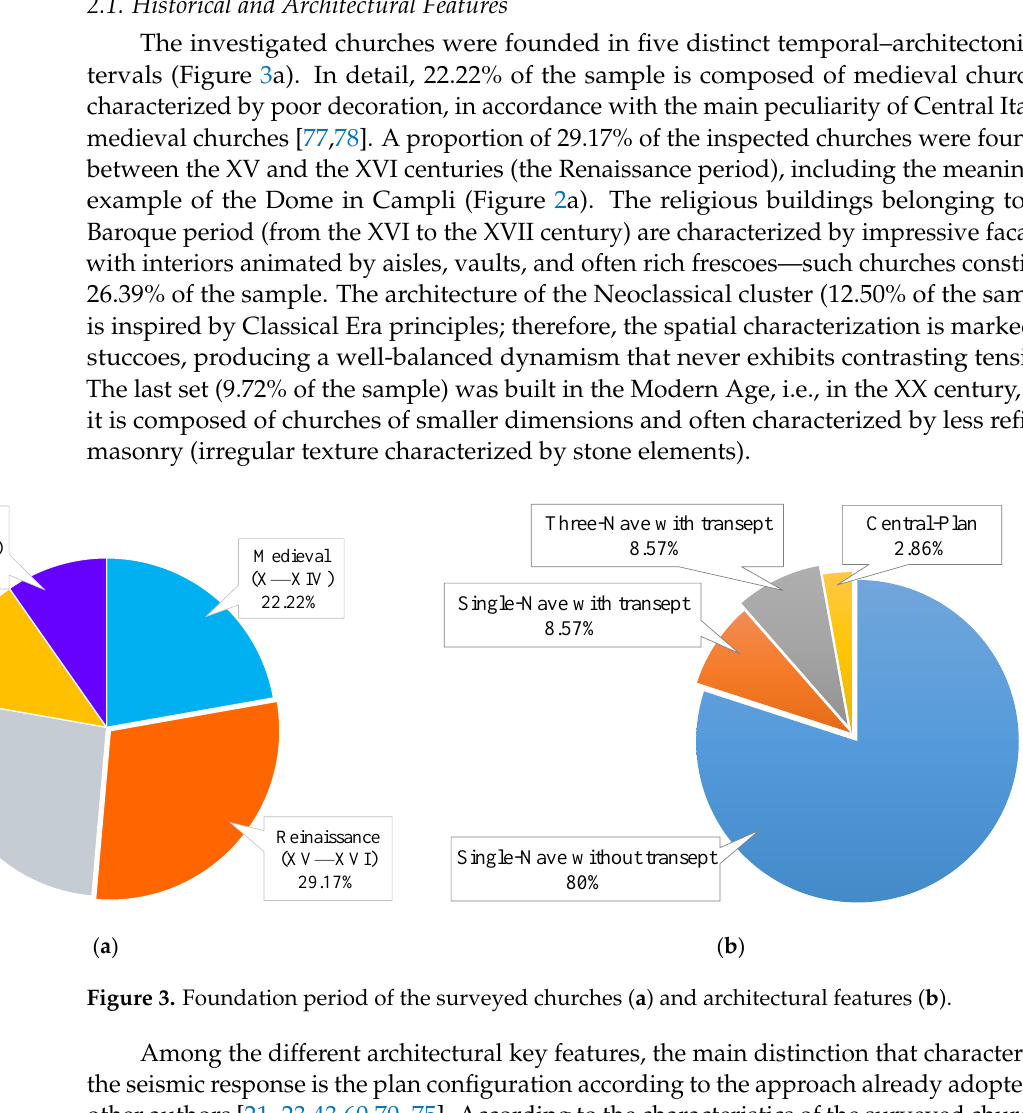
Figure 2. Two examples of surveyed churches: ( a ) Holy Mary in Platea in Campli, Teramo (XV Cen.); ( b ) Abbey of Holy Mary in Montesanto in Teramo (X – XI Cen.).